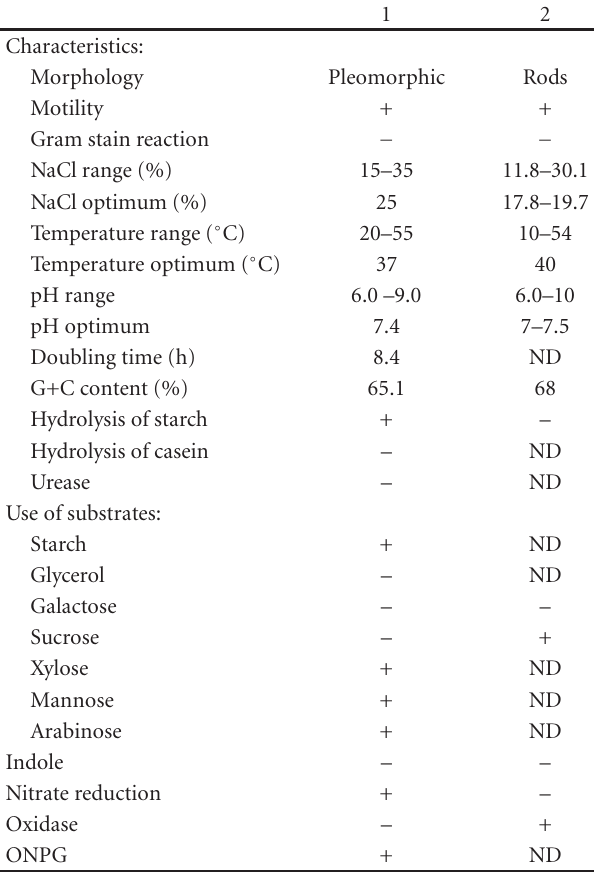
Table 2: Di ff erential characteristics of ETD6 and Halorubrum xinji- agense . Strains: 1, strain ETD6 (tested in this study); 2, Halorubrum xinjiangenese AS 1.3527 T [35]. +, Positive; − , negative; ND, no data